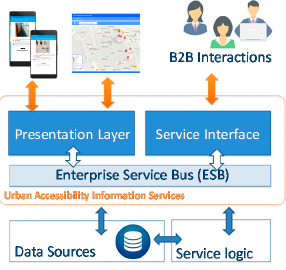
Figure 11. Urban Accessibility Information Service Architecture.